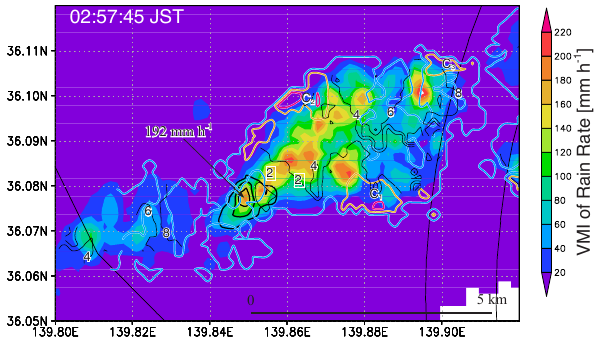
Fig. 12. The horizontal distribution of VMI( Z DR ) and the expected arrival time of the maximum rainfall on the ground superimposed over VMI( R ) estimated from the MRI C-band polarimetric radar at 02:53 JST. Solid colored contours indicate VMI( Z DR ) at altitudes above the freezing level from 0 dB with a contour interval of 3 dB, and dashed-blue contours depict VMI( Z DR ) located at altitudes lower than the freezing level at 0 dB. Black contours with numbers indicate the arrival time of the maximum rainfall in minutes. C 1 and C 2 indicate the locations of high Z DR columns.